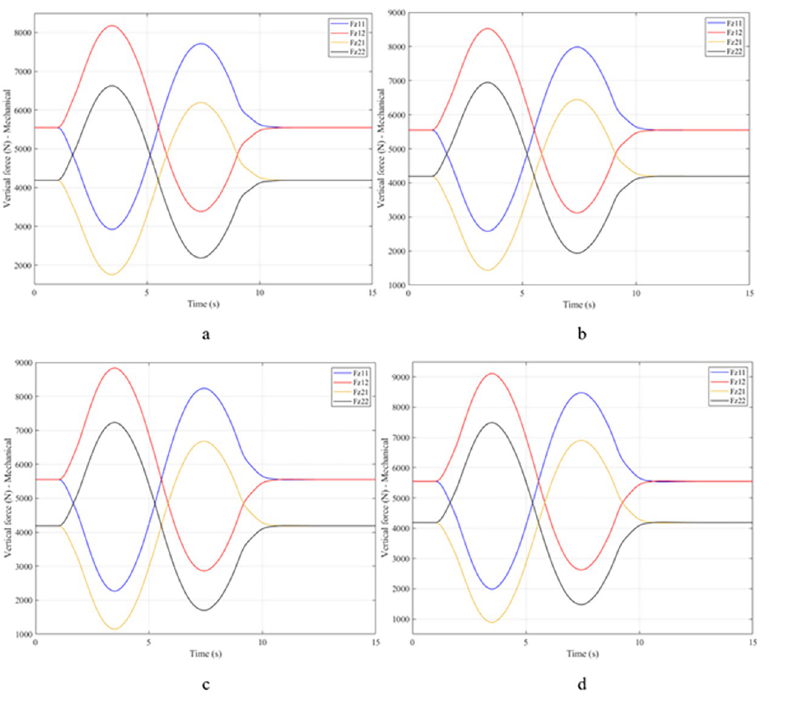
Fig 14. Vertical force–Mechanical.